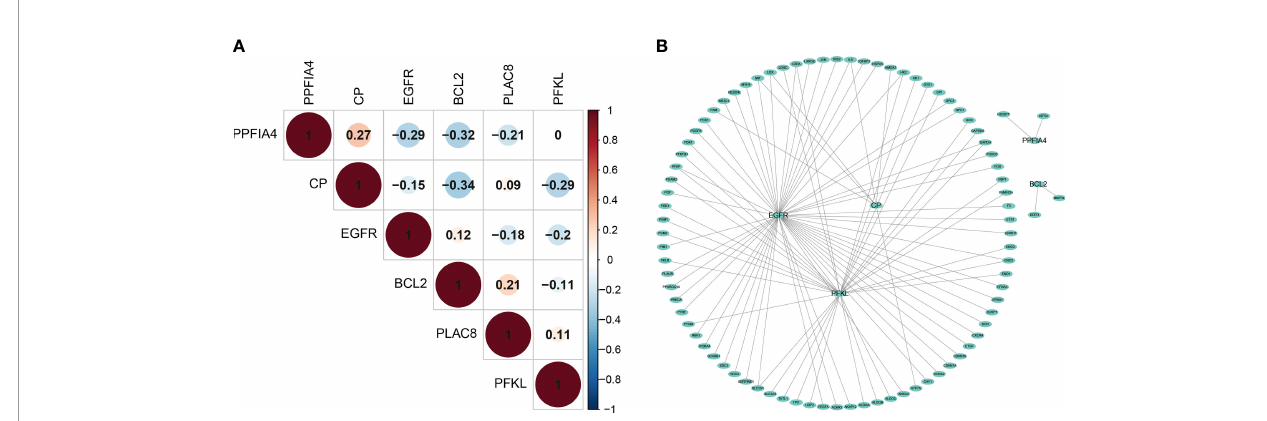
FIGURE 4 | The interaction mechanism between Prognostic Genes. (A) The spearman correlation analysis based on the expression of the 6 hypoxia-related signatures. (B) The Protein – Protein network interactions including 200 hypoxia-associated